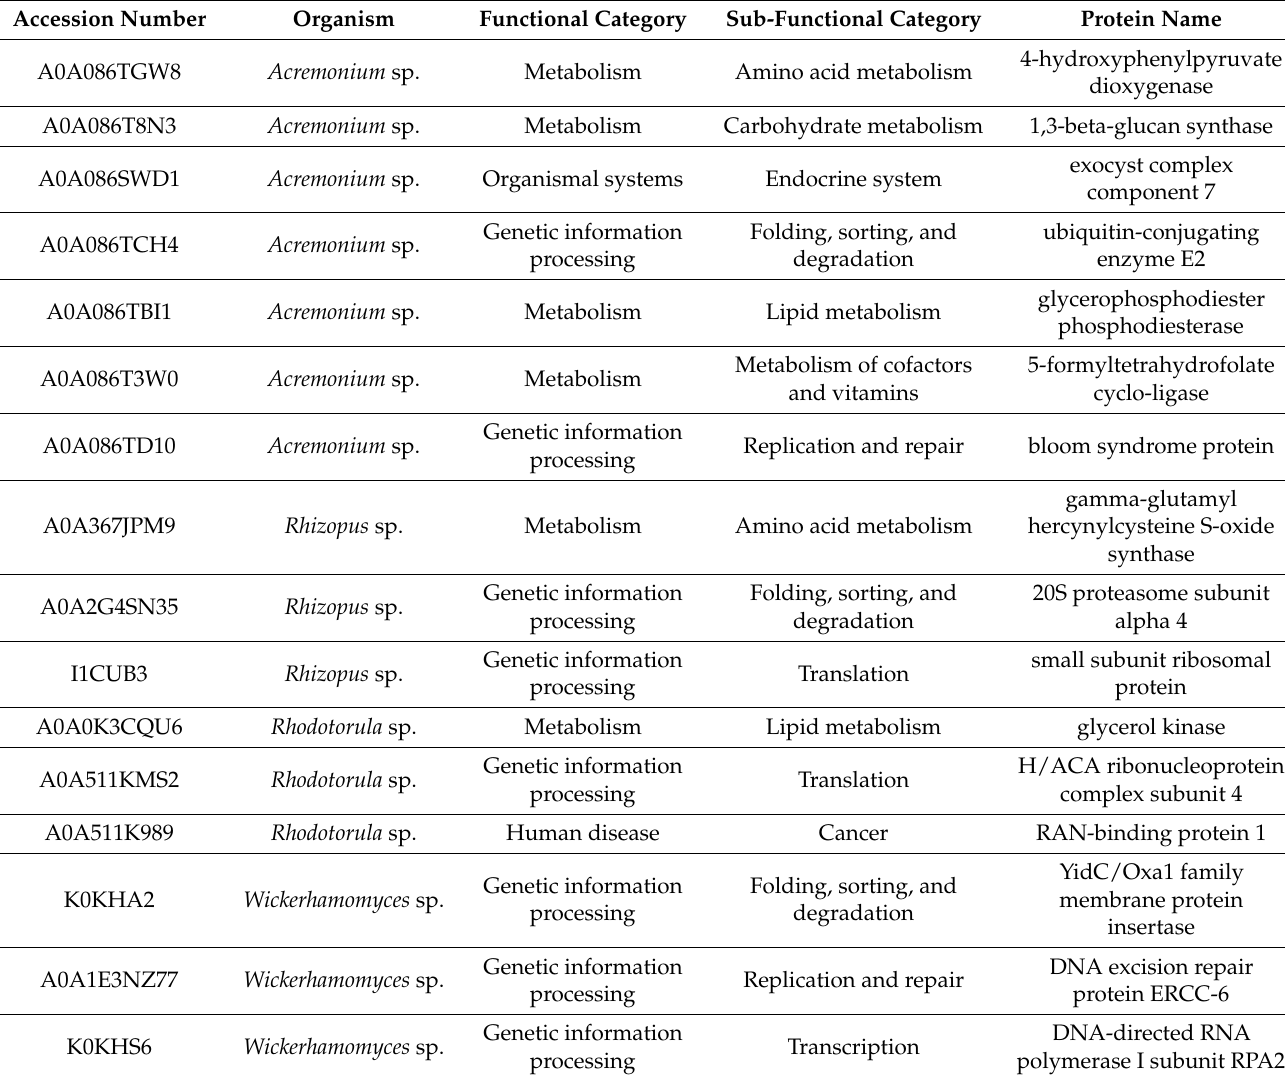
Table 4. Functional categories of the unique proteins in the persisted